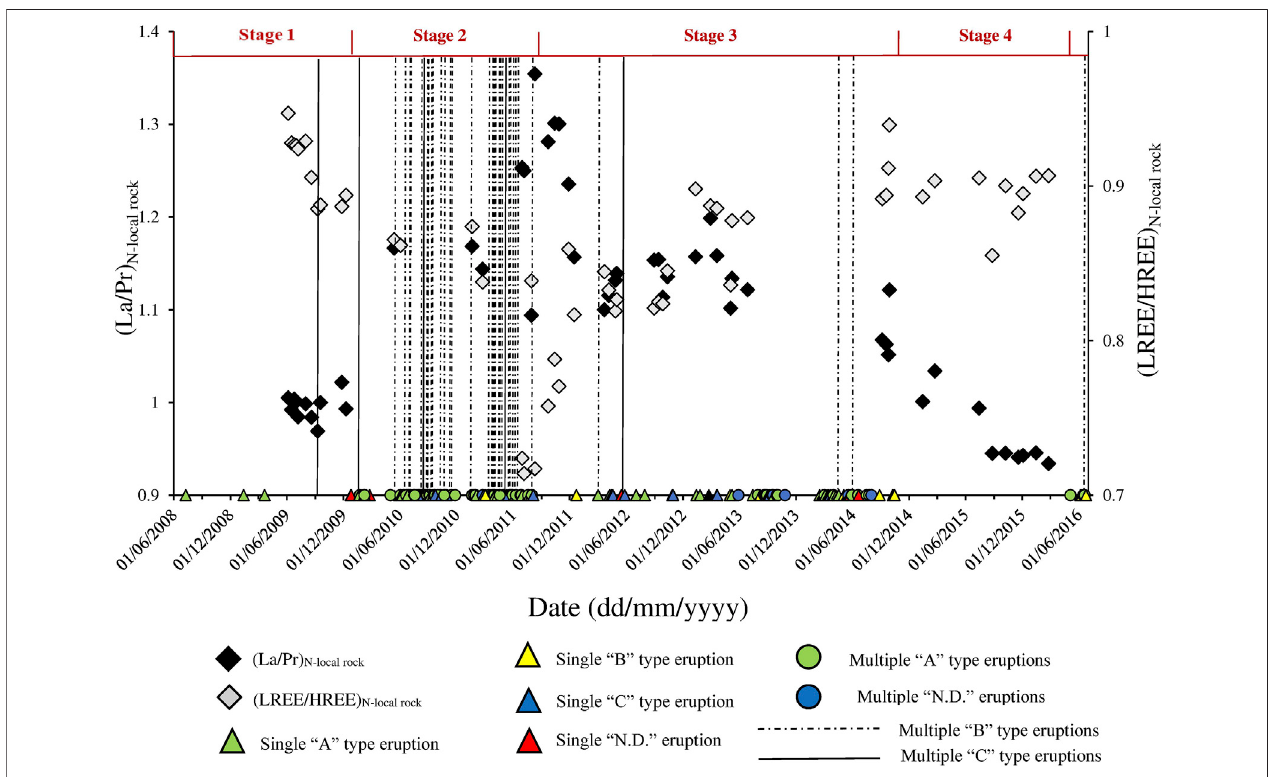
FIGURE 4 | (La/Pr) N-local rock and (LREE/HREE) N-local rock vs. time.